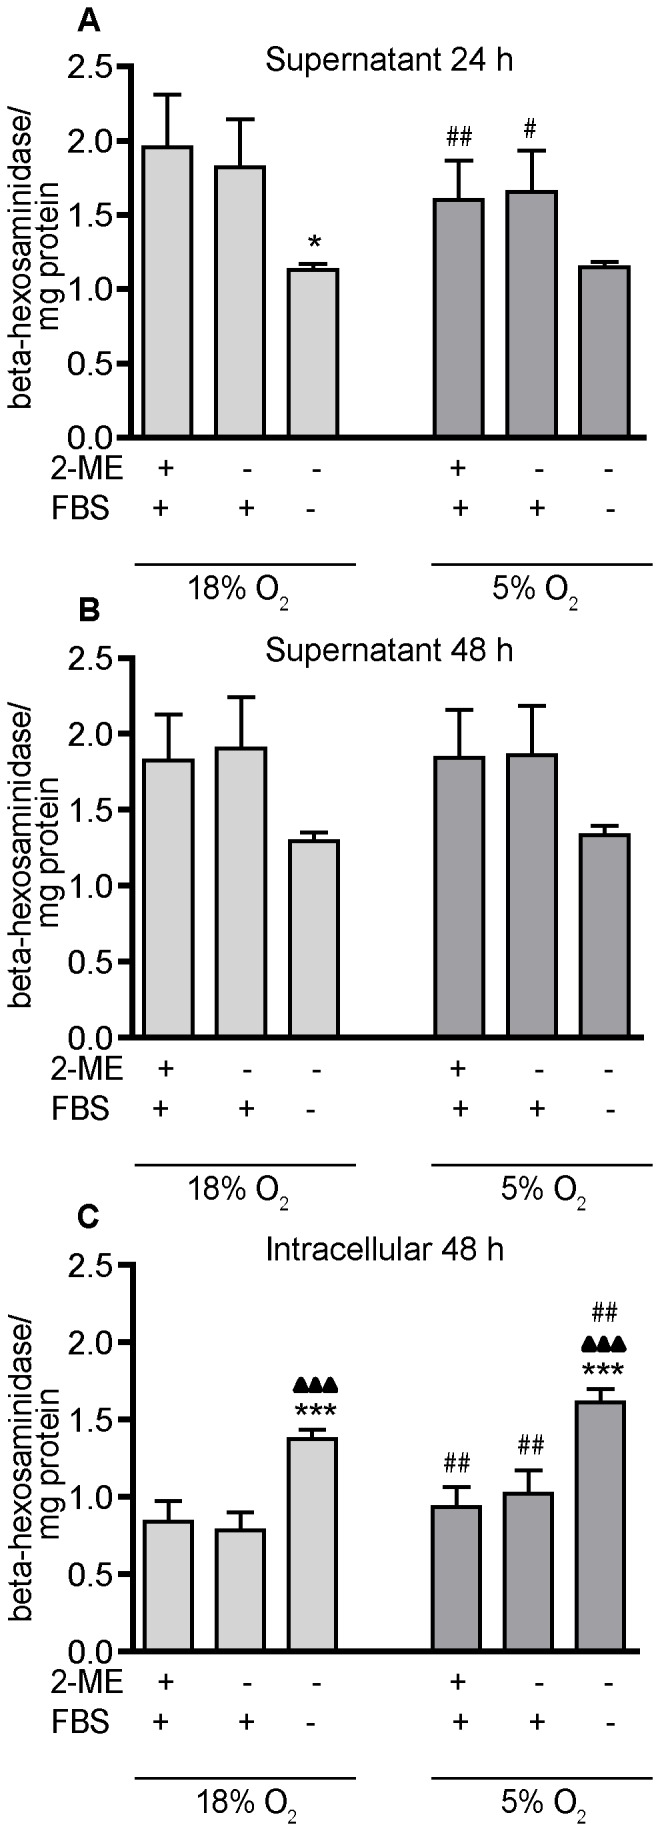
Influence of O2 tension, 2-ME and serum on release of β-hexosaminidase.Differentiated THP-1 cells constitutively release β-hexosaminidase that is measurable in the conditioned medium (supernatant) after 24 h (A) or 48 h (B) of culture. β-Hexosaminidase is also detected in cell lysates (C). β-Hexosaminidase activity per well was normalized to the concentration of protein in the same well as determined using the BCA protein assay. Data are presented as mean ± SEM (n = 3 independent experiments). *Significantly different from +2-ME+FBS (standard culture conditions) under the same oxygen tension (one-way ANOVA and post hoc Tukey’s test); ▴Significantly different from –2-ME+FBS under the same oxygen tension (one-way ANOVA and post hoc Tukey’s test); #Significantly different from the same culture condition in the 18% O2 group (e.g., 18% O2
versus 5% O2) by Student’s t-test. *, #, ▴
p<0.05; **, ##, ▴▴
p<0.01; ***, ###, ▴▴▴
p<0.001.